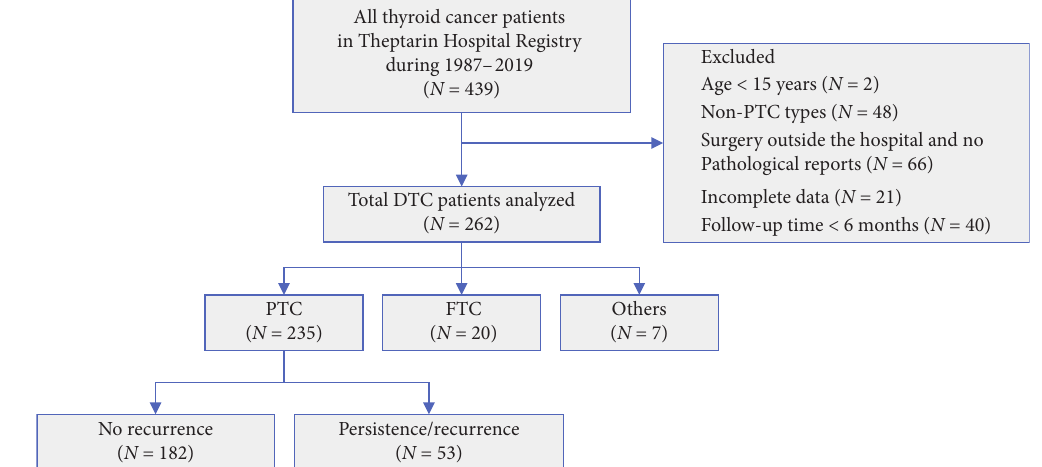
Figure 1: Flowchart depicting the protocol used in this